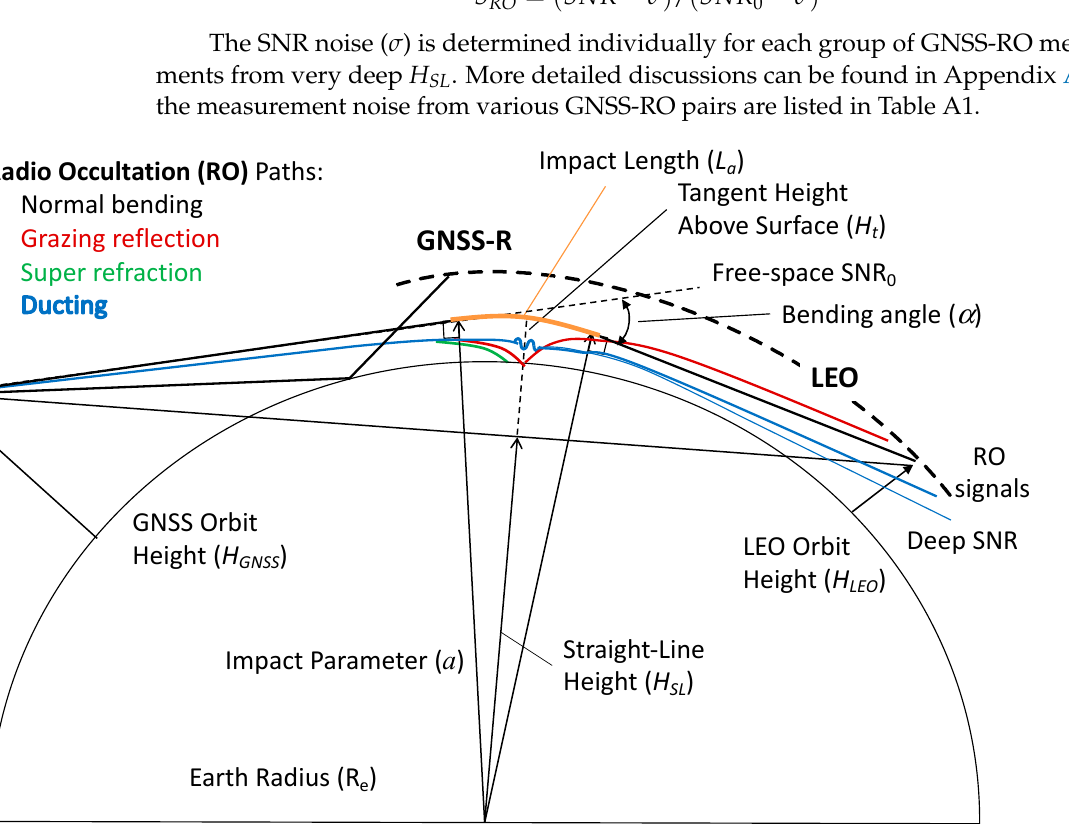
Figure 1. Schematic diagram to illustrate GNSS-RO observation geometry with several key bending scenarios in color for normal bending, grazing reflection, super refraction, and ducting conditions. The orange line in the middle of the ray path denotes the section where radio wave propagation is significantly impacted by the atmosphere. The horizontal extent of this section is impact length ( L a ). The refraction and diffraction from the water vapor layer ducting are most likely to produce an RO signal at a deep straight-line height ( H SL ) or large bending angle ( a ). The RO receiver signal amplitude (signal-to-noise ratio or SNR), impact parameter ( a ), LEO satellite height ( H LEO ), GNSS satellite height ( H GNSS ), and tangent height ( h t ) are also defined in the diagram.